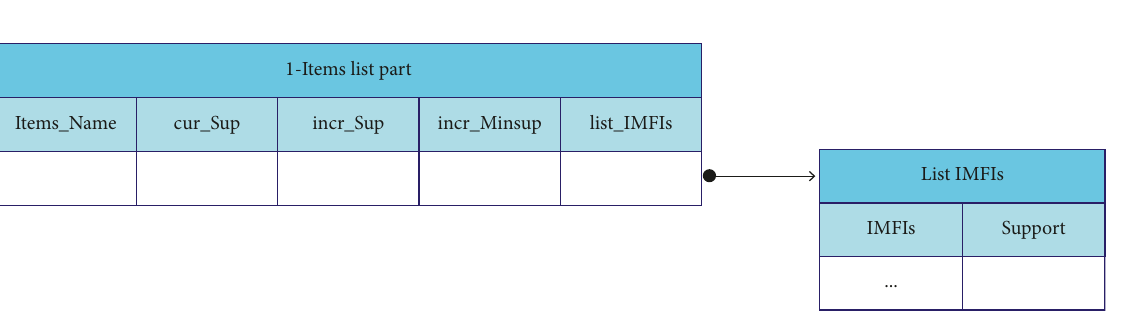
Figure 2: PD_IMFI